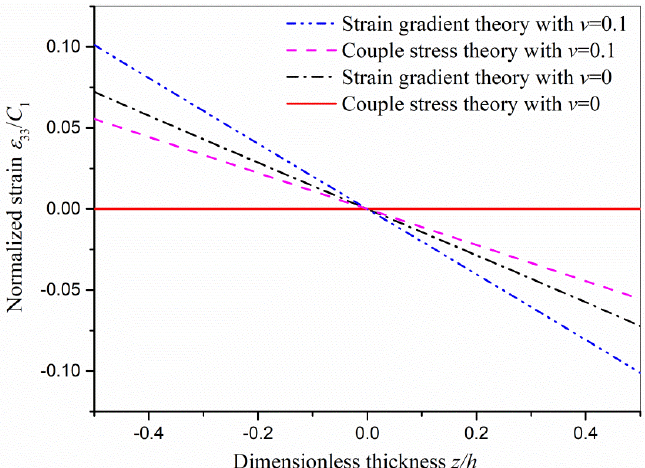
Figure 3. Normalized strain of a plane ‐ strain beam along the thickness direction.